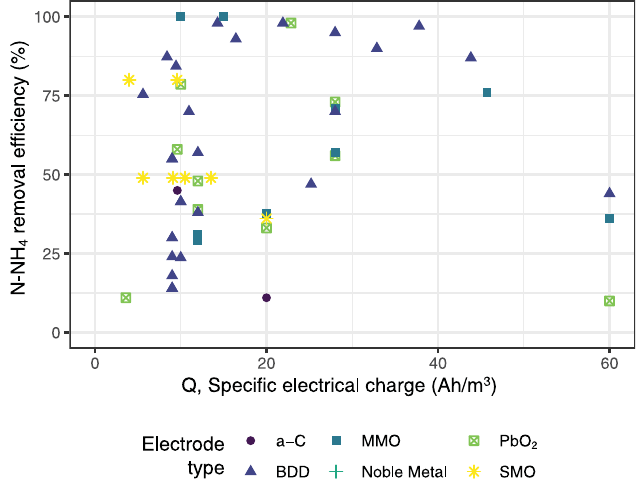
Fig. 4. NH 4 removal ef fi ciencies versus the speci fi c electrical